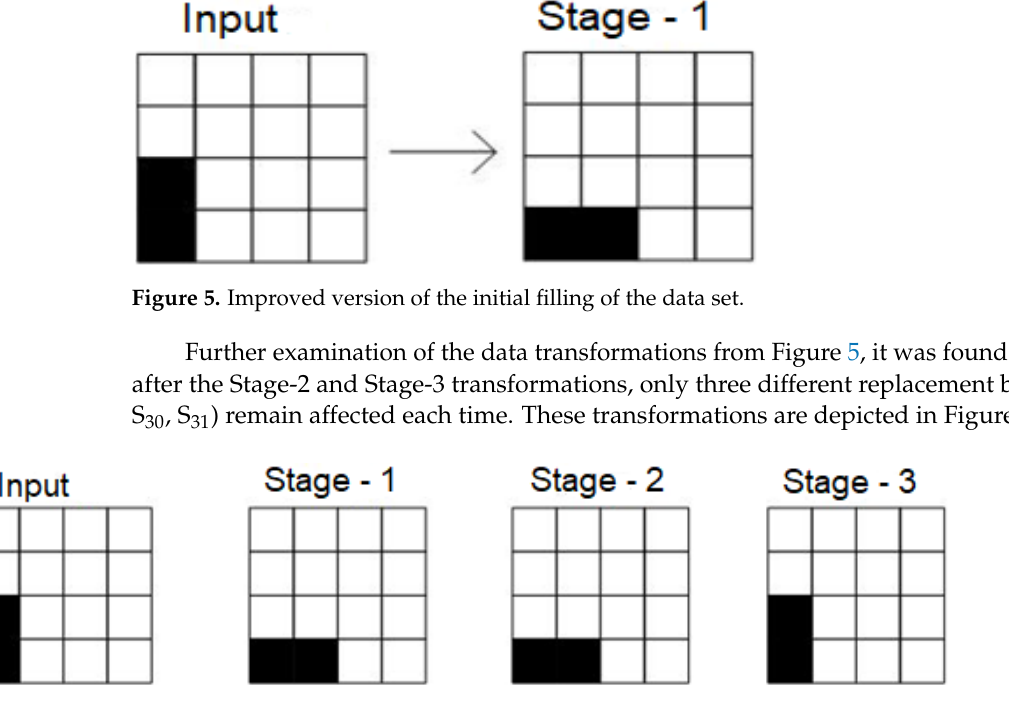
Figure 4. Variant of the initial filling of the data set.